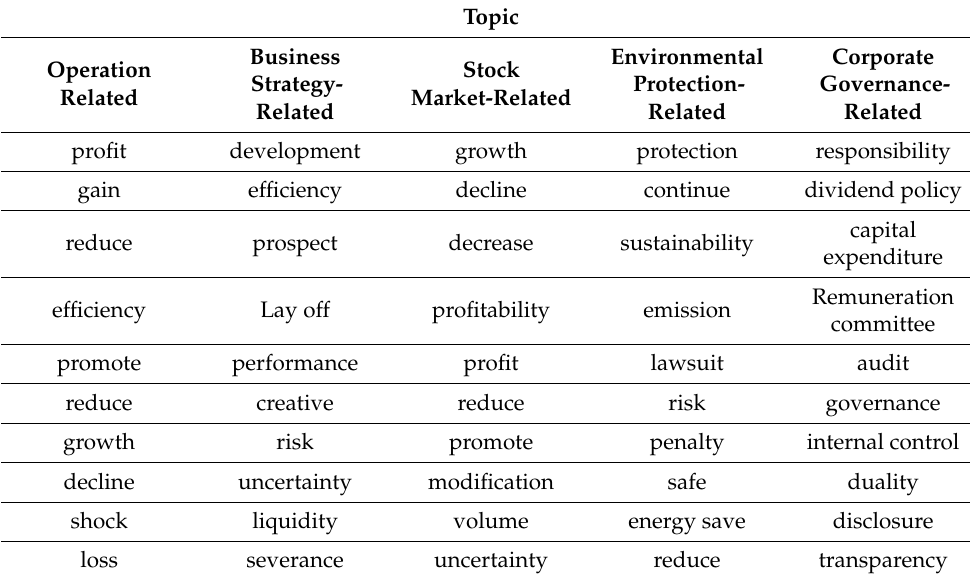
Table 6. The word list for each topic (Top 10 words).